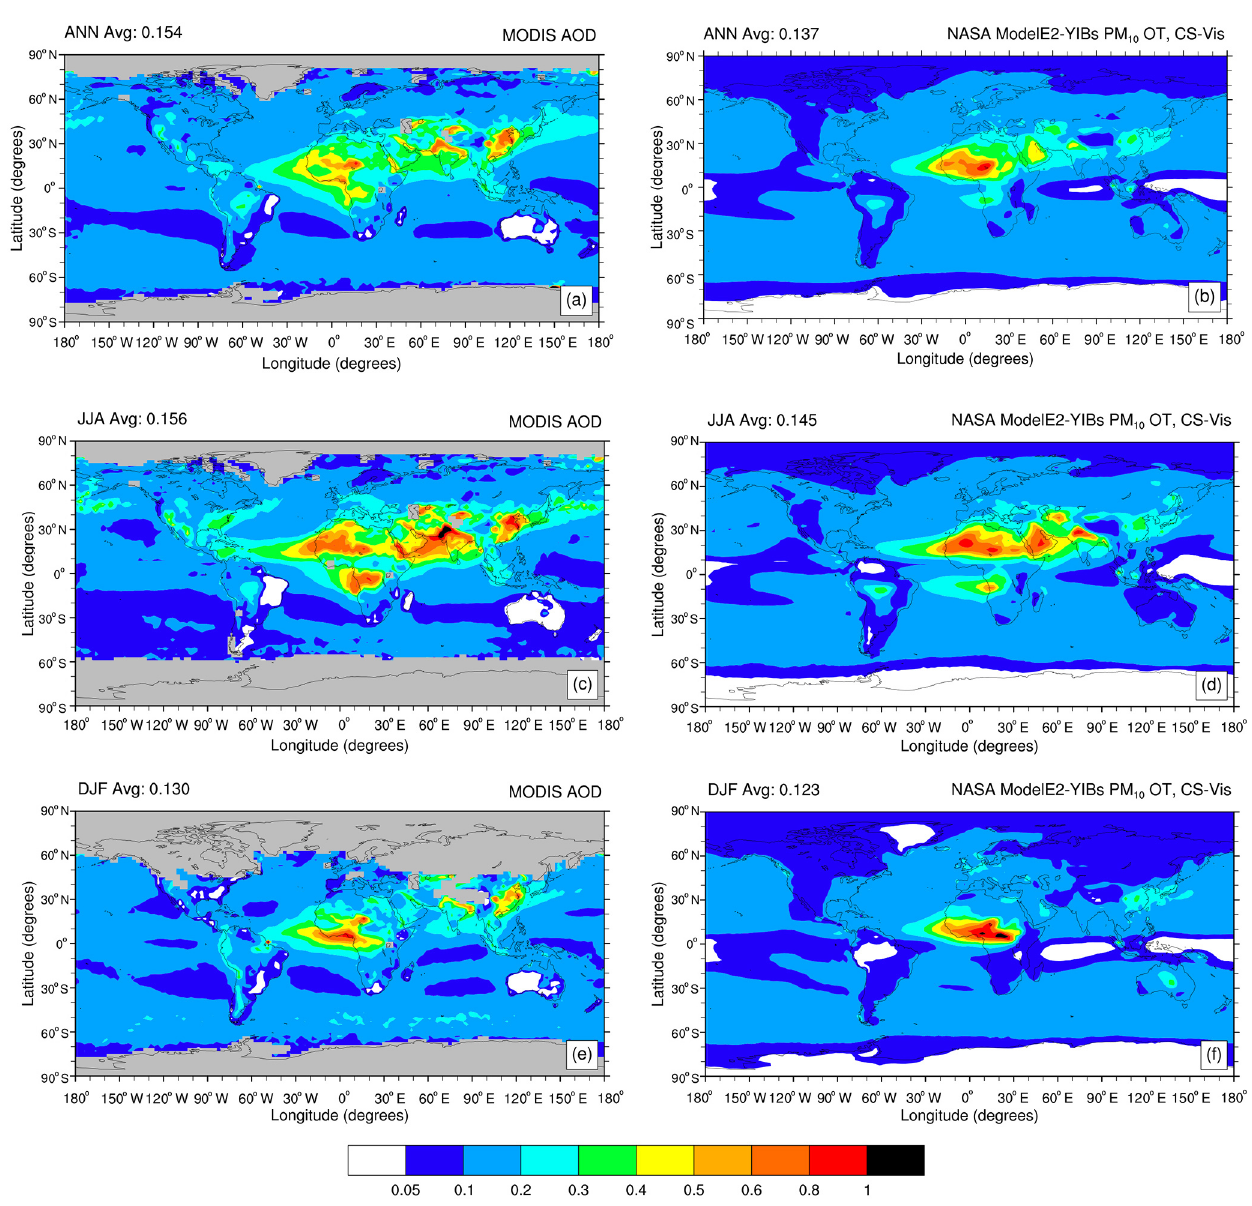
Figure 1. Annual and seasonal average coarse aerosol optical depth (AOD) seen by (a, c, e) the MODIS instrument (at 550nm; averaged over 2000–2007) and (b, d, f) NASA ModelE2-YIBs in the control present-day simulation ( ∼ 2000s). Global mean values are given in the upper left corner of each map. Only boreal summer (JJA) and winter (DJF) seasonal averages are shown. For NASA ModelE2-YIBs, only clear-sky (CS) values in the visible (Vis) range are used to define PM 10 optical thickness